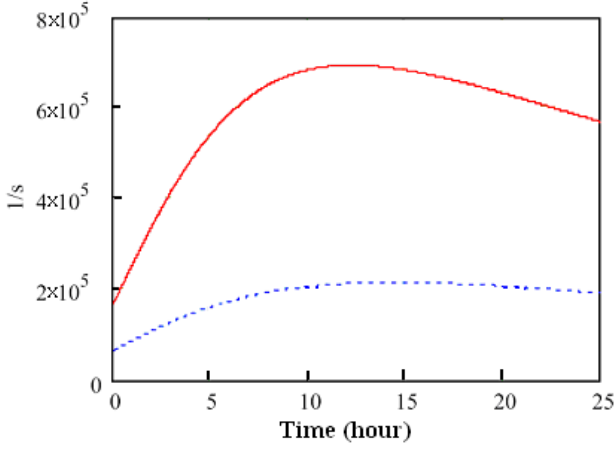
FIG. 6. (Color) Calculated longitudinal beam loss rate in unit of particles per second for a typical store using the IBS model; the red curve is for the proton bunch and the blue dashed line is for the antiproton bunch.